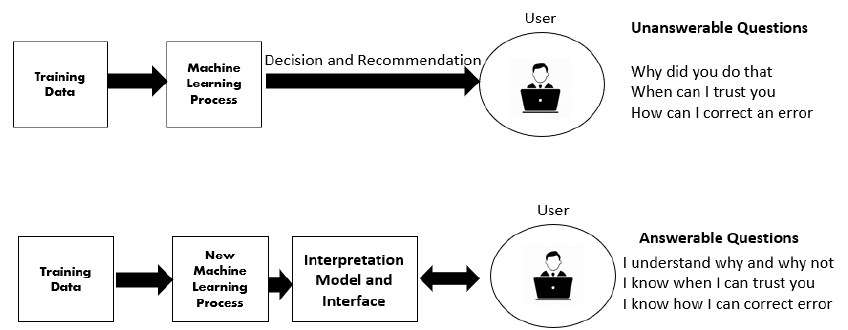
Figure 3. How explanation methods provide value to the end